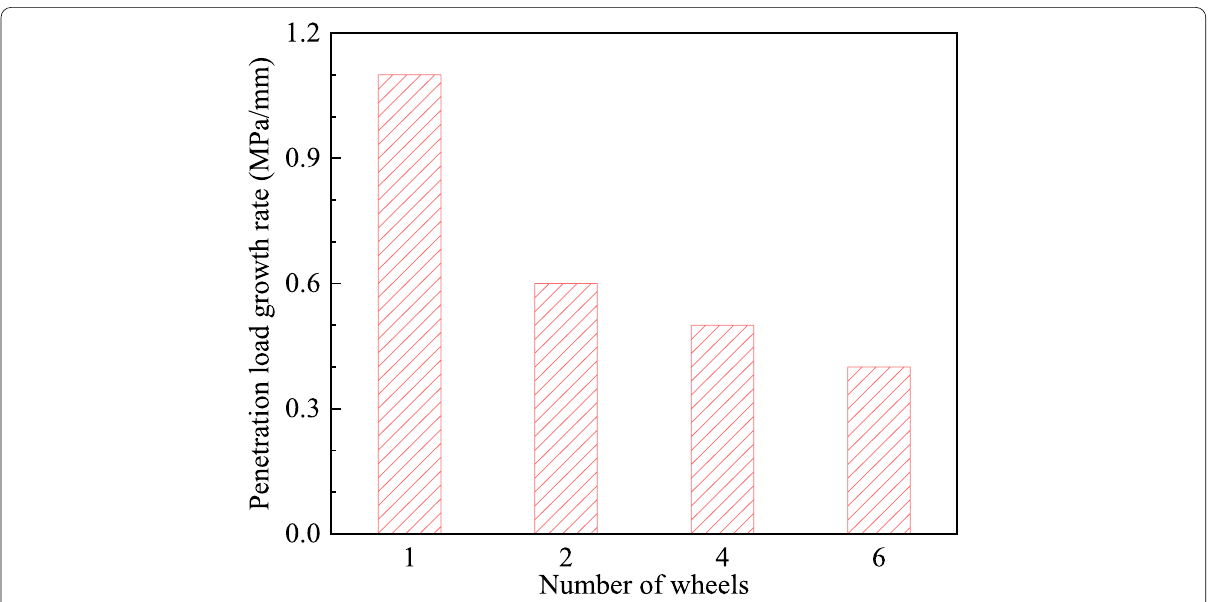
Fig. 11 Penetration load growth rate with different number of wheels